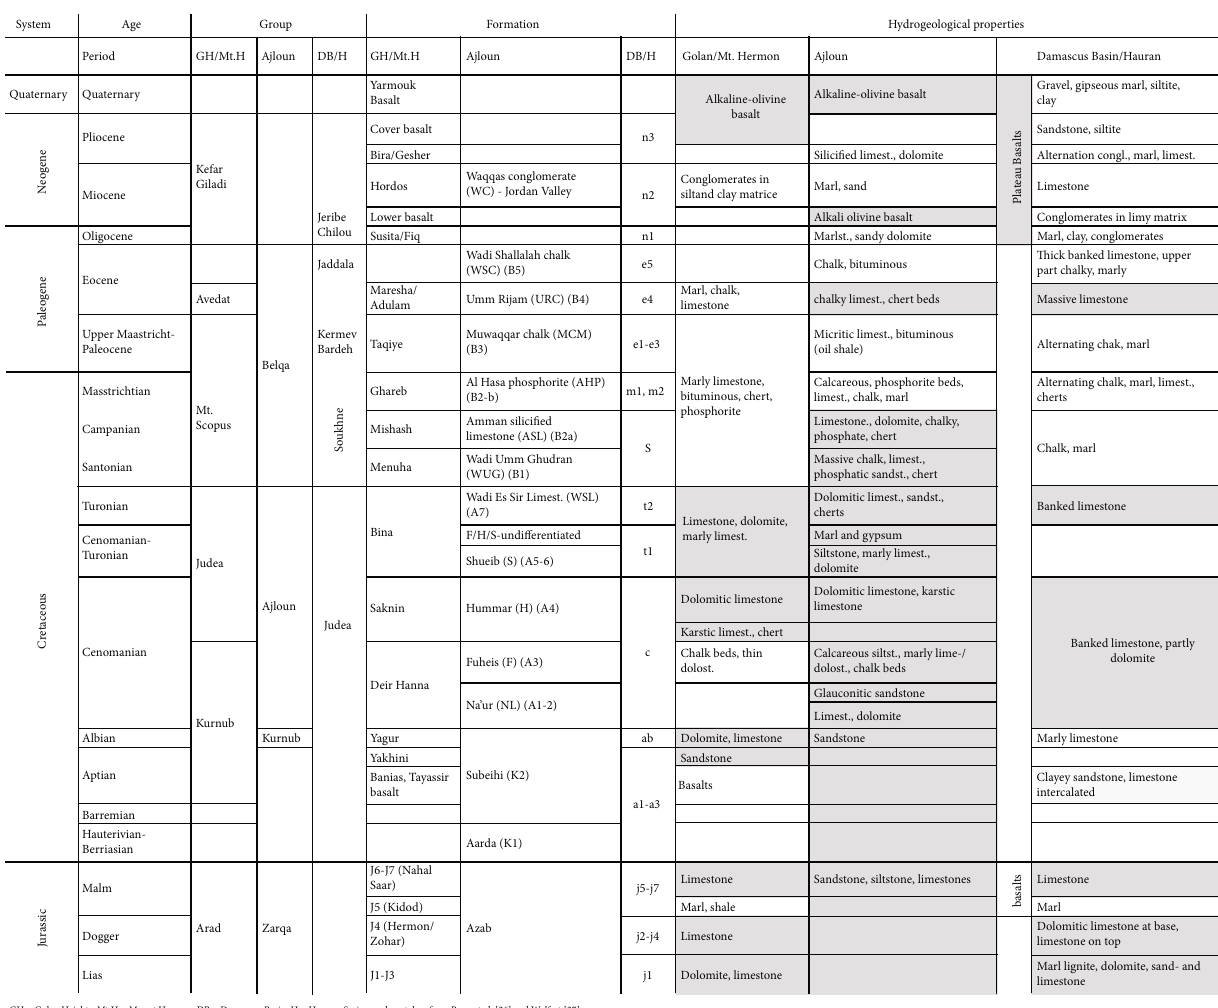
Figure 3: Stratigraphic table of the hydrogeological formation in the Yarmouk